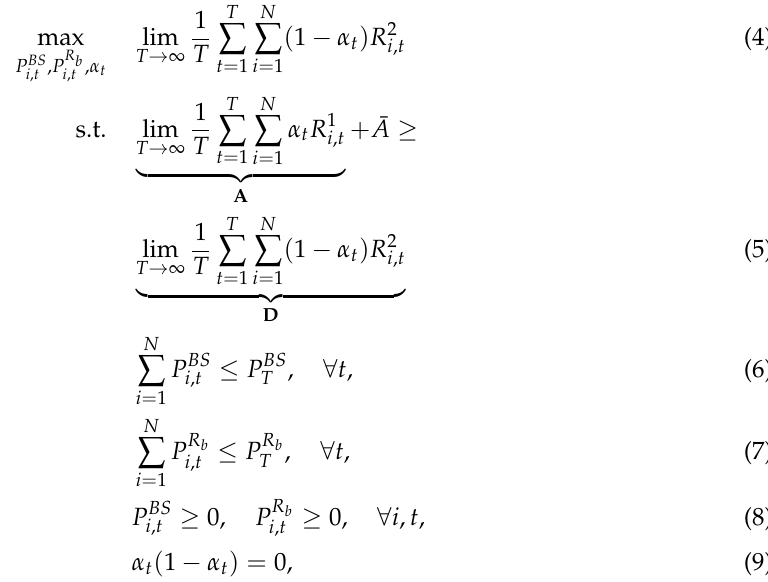
represent optimal and R 2 ∗ , i , t i , t